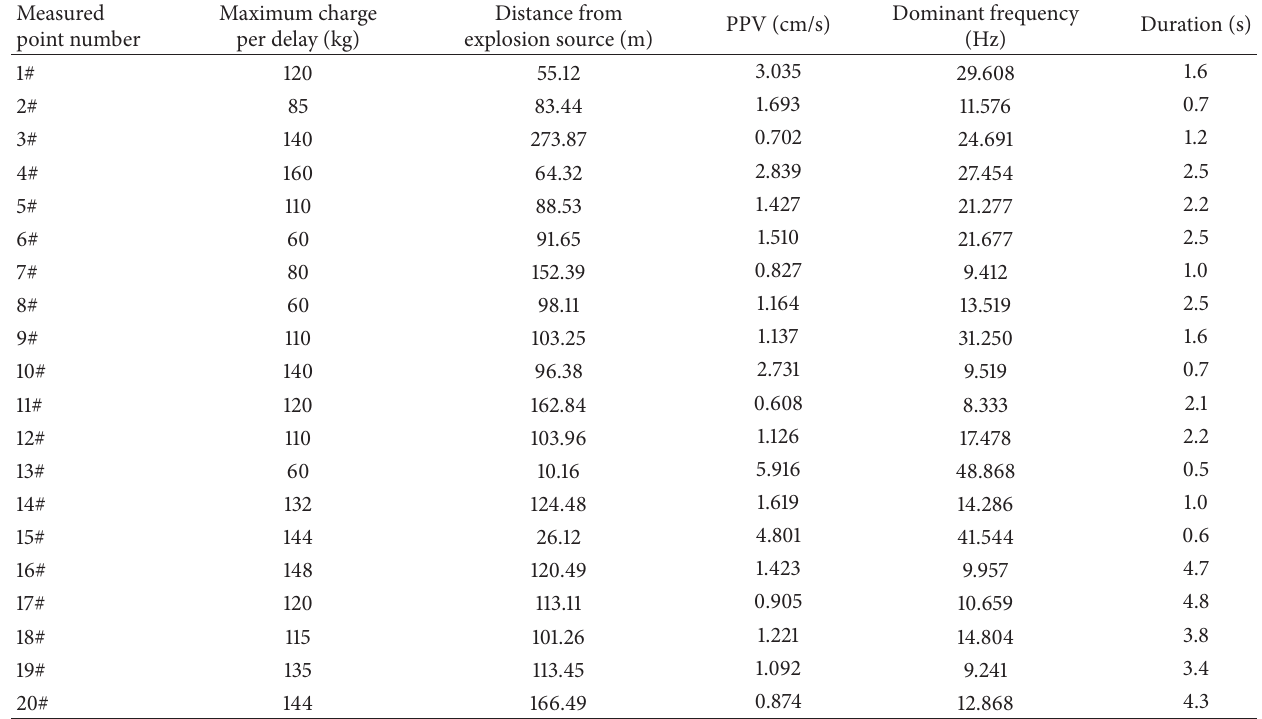
Table 2: The results measured at the buildings.